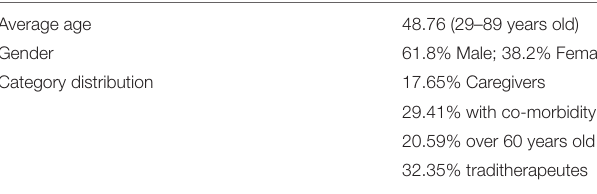
TABLE 1 | Description of the characteristics of the